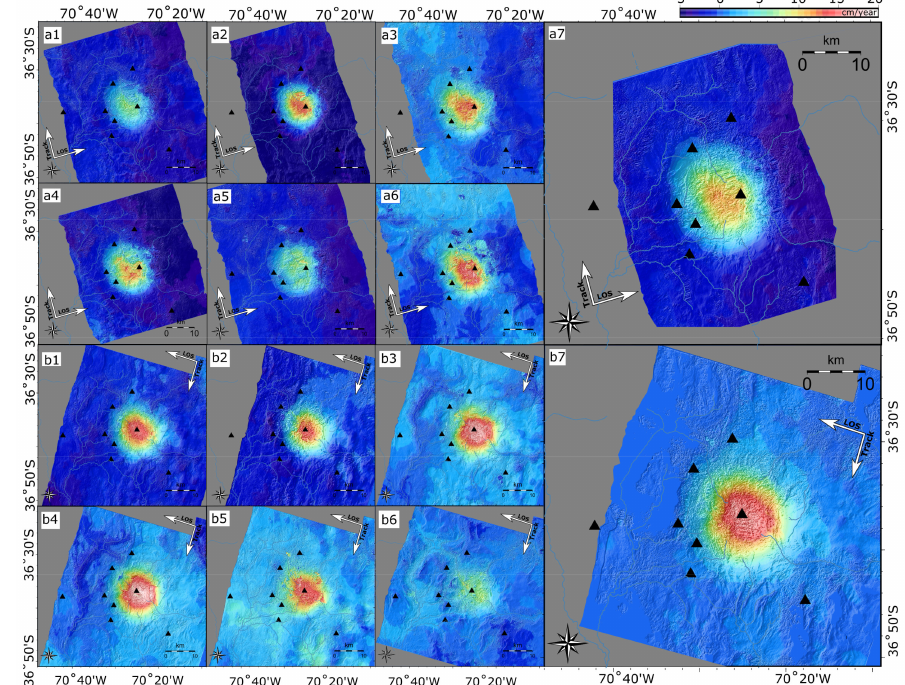
Figure 5. Deformation velocities (unwrapped interferograms / time span, in cm / year) used to create a stack. The images with labels ( a1 – a6 ) and ( b1 – b6 ) correspond to six products each, in ascending and descending configurations, respectively (see Table 1). Each product has been normalized to a one-year period for the stacking process; see Table 1 for more details. Images ( a7 ) and ( b7) correspond to the mean velocities for each satellite configuration; on average, the deformation velocity was 11 cm / year for the ascending products ( a7 ) and 13 cm / year for the descending products ( b7 ).